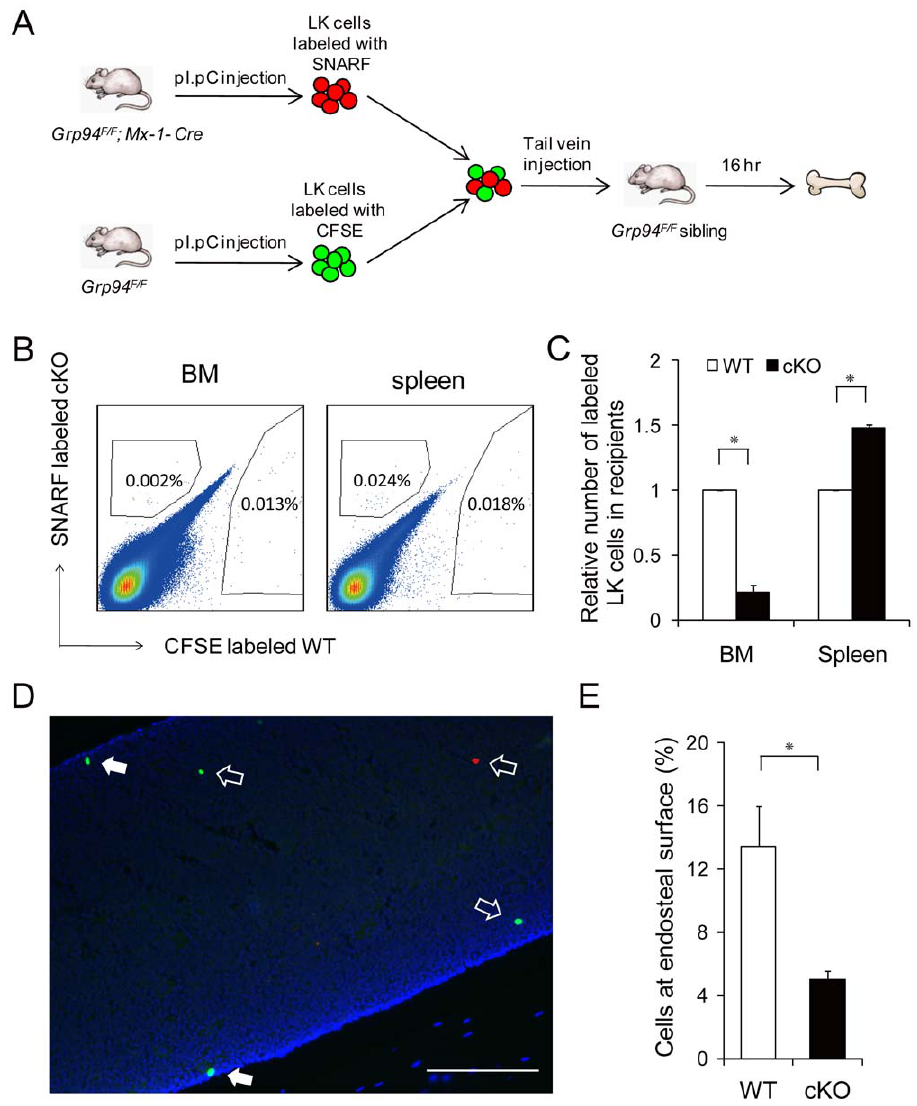
Figure 7. Grp94 KO HSCs displayed impaired interaction with the niche. A) Scheme of the in vivo competitive lodgment assay. B) Representative flow cytometric analysis of CFSE-labeled WT LK cells and SNARF-labeled cKO LK cells with host BM and spleen cells. C) Summary of LK cells homed to the BM and spleen (n=4 for BM, n=2 for spleen), with the level of WT cells in BM and spleen set as 1. D) Bone section of a recipient femur. WT LK cells were labeled with CFSE (green); cKO LK cells were labeled with SNARF (red); and nuclei were stained with DAPI (blue). Solid arrows indicate cells lodged in the endosteal region (within two cell diameters from the endosteal surface), while open arrows indicate cells located in the central marrow. Scale bar represents 1 mm. E) Summary of the percentage of labeled LK cells found at the endosteal region among those homed to BM from 3 independent experiments. All data are presented as mean 6 s.e., *p , 0.05.